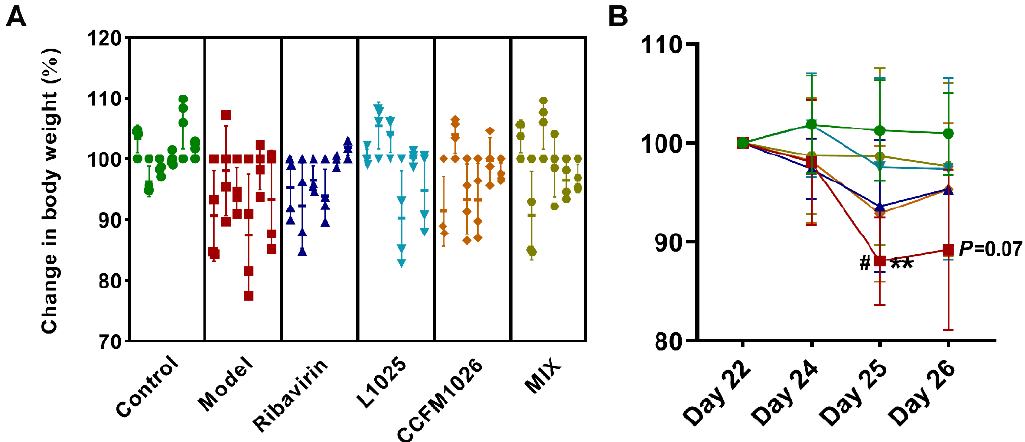
Figure 2. Change in body weight of mice ( A ). Changes in body weight of every mouse ( B ). Changes in weight of mice in each group, and statistical analysis for the model group: **, day 25 vs. day 22; #, day 25 vs. day 24; and p = 0.07, day 26 vs. day 22 (two-way ANOVA and Tukey’s multiple comparisons).